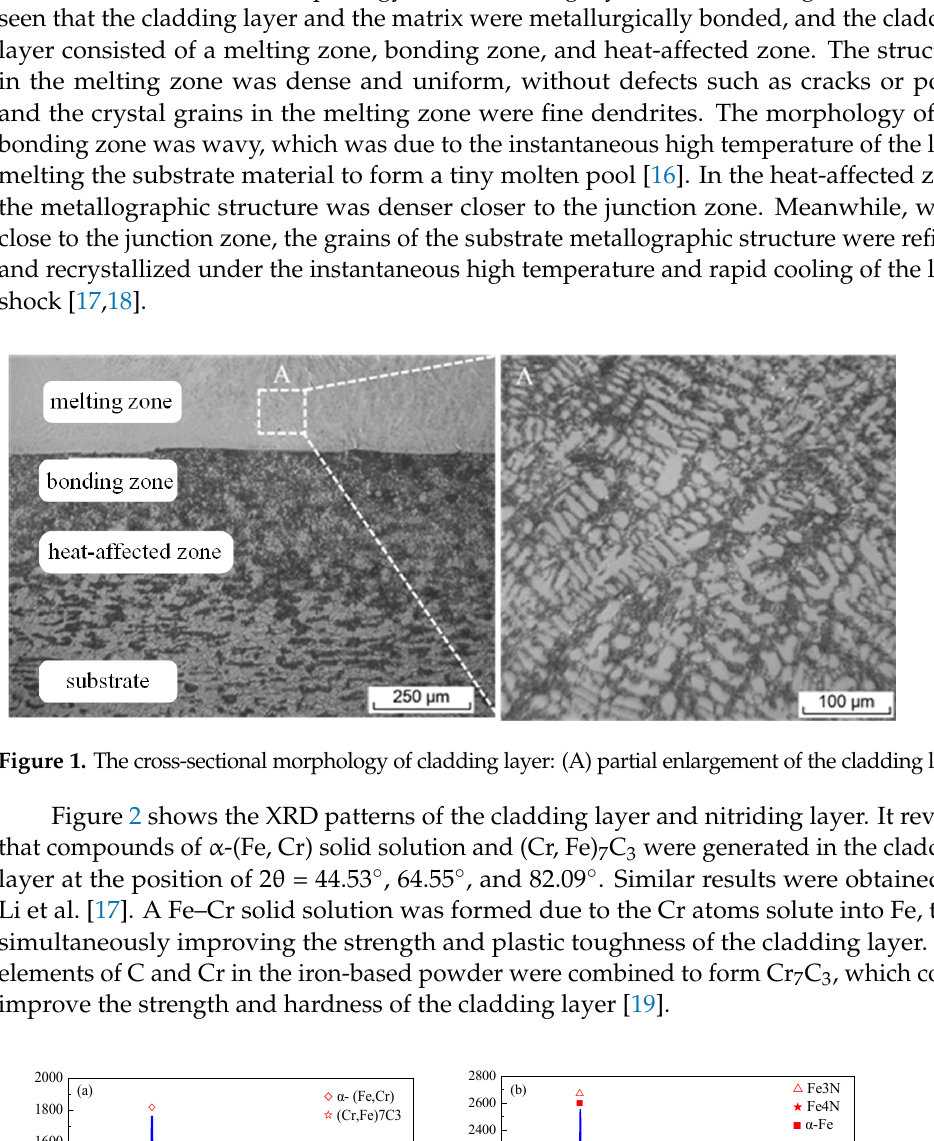
improve the strength and hardness of the cladding layer [19].